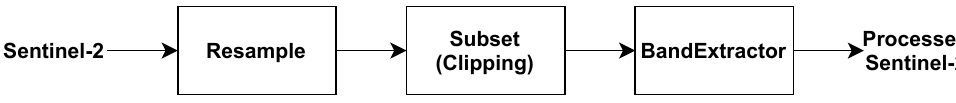
Figure 5. SNAP processing pipeline for Sentinel-2.